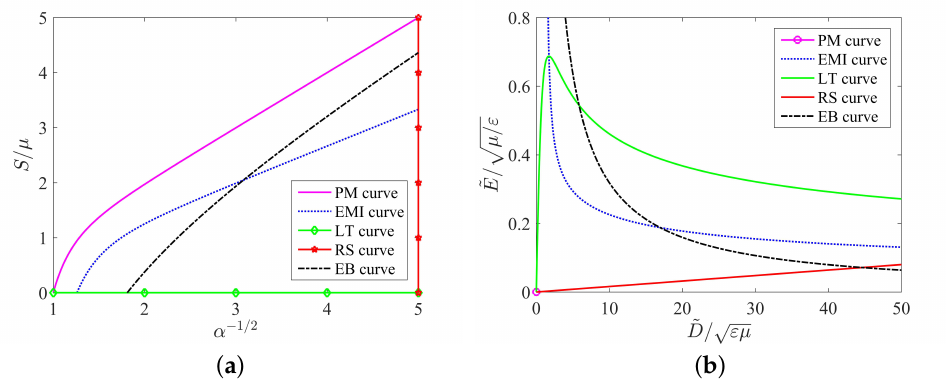
Figure 3. A thermodynamic state of the dielectric film is represented by ( a ) a point in the stress-stretch plane or ( b ) a point in the nominal electric field-nominal electric displacement